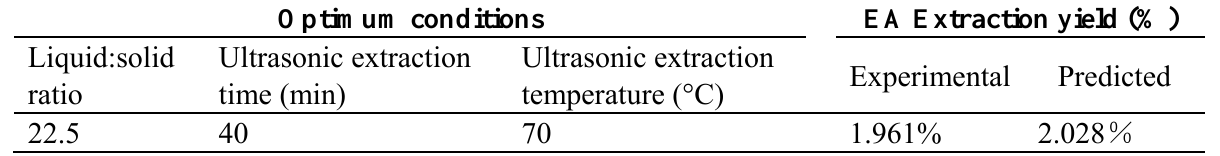
Table 4. Predicted and experimental values of the responses under optimum